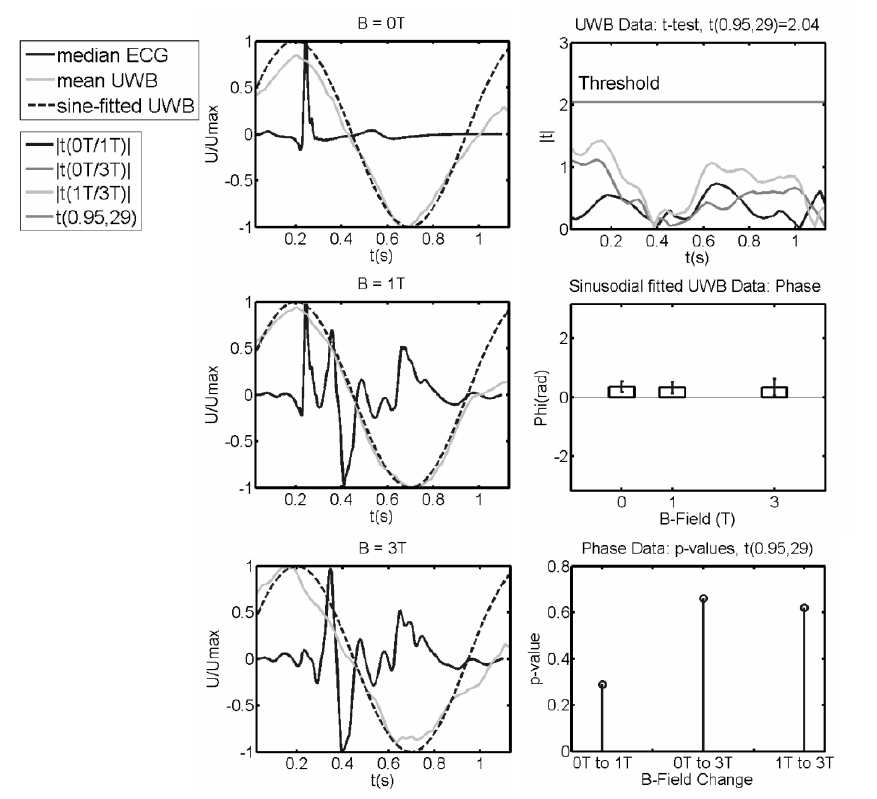
Figure 10. Left: comparison of the median of 30 ECGs (EIII), the corresponding reconstructed mean UWB signals and the mean of the sinusoidal fitted UWB data for B = 0T, 1 T and 3 T. Upper right: result of the t -test for each time step in t = [0,…,1.1 s]. 0 Middle and lower right : comparison of phase of the fit and p-values of the t -test on the